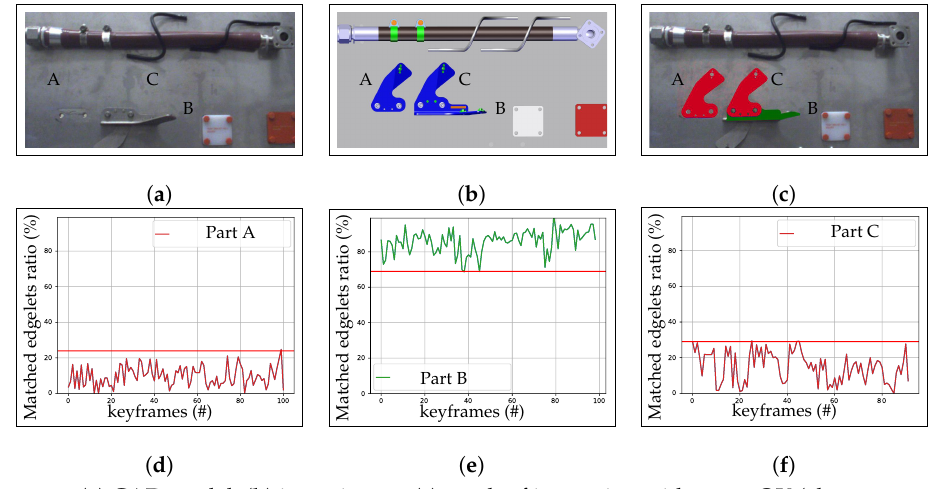
Figure 17. ( a ) CAD model; ( b ) input image; ( c ) result of inspection with green OK (element present) and red NOK (element absent or incorrectly mounted); ( d – f ) the matched ratio (curve) and threshold matched th (red horizontal line), respectively, computed on the three different cases: element A (absent) in red, element B (present) in green, and element C (incorrectly mounted) in